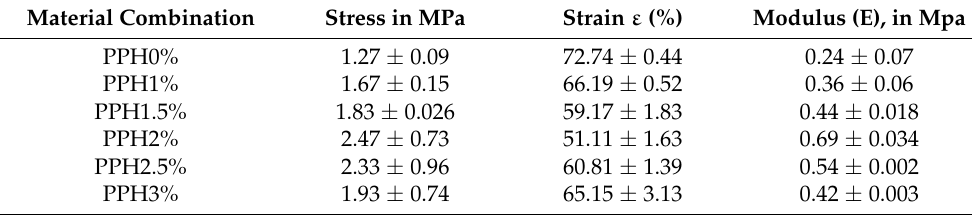
Table 2. properties of PVA/PVP/HNr hydrogel under unconfined compression.